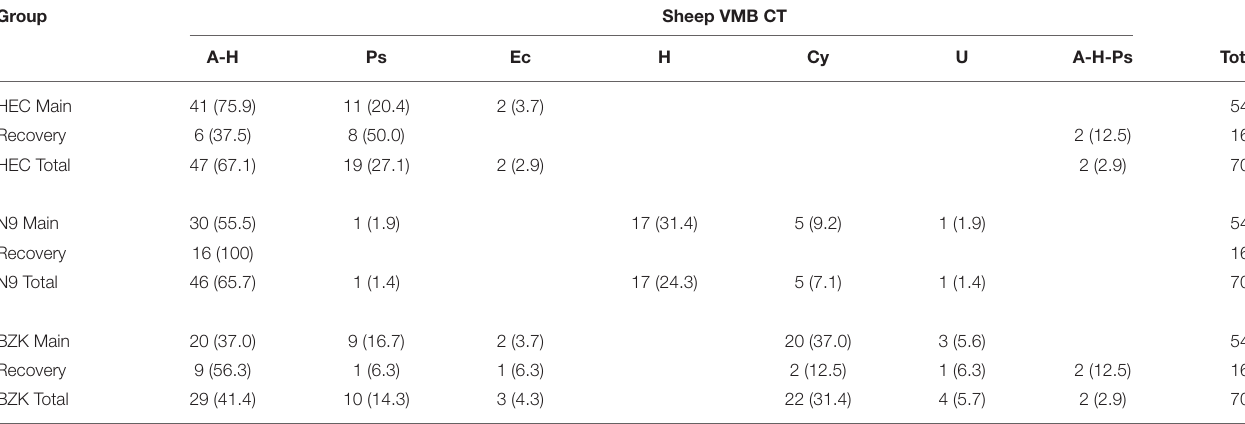
TABLE 2 | Phase 3 (main vs. recovery period) VMB CT distribution.